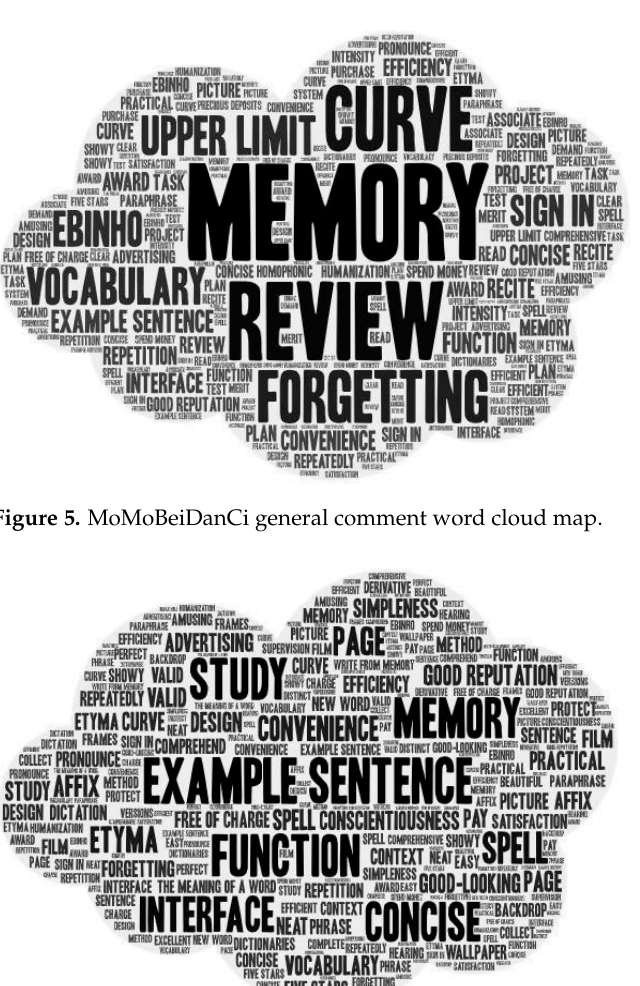
Figure 4. BaiCiZhan general comment word cloud map.